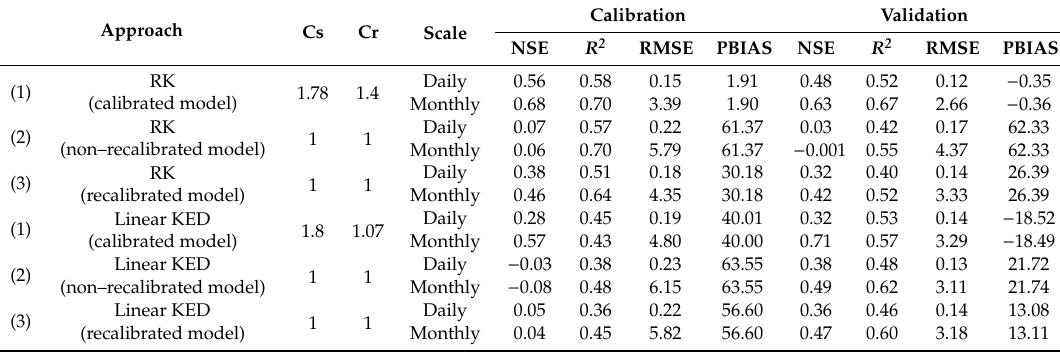
Table 5. Values of the correction coe ffi cients (Cr and Cs) and goodness of fit to the daily and monthly streamflow data for the calibration and validation periods for each model